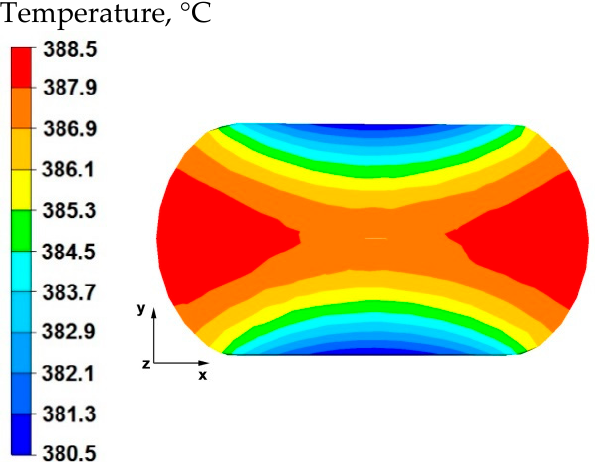
Figure 1. Distribution of temperature values on the surface of the cross-section of the sample with modeled discontinuity—after deformation with 35% reduction.